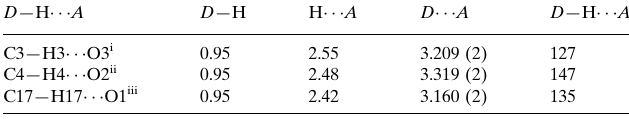
Hydrogen-bond geometry (A˚ , (cid:1)